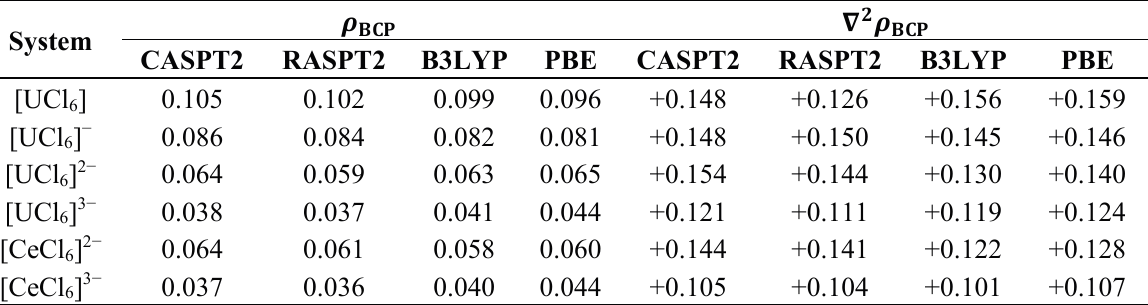
Table 4. Values of the electron density ( (cid:2025) ) and its Laplacian ( ∇ (cid:2870) (cid:2025) ) at the M–Cl critical point of metal hexachlorides, evaluated at theoretically optimised geometries. All values are in